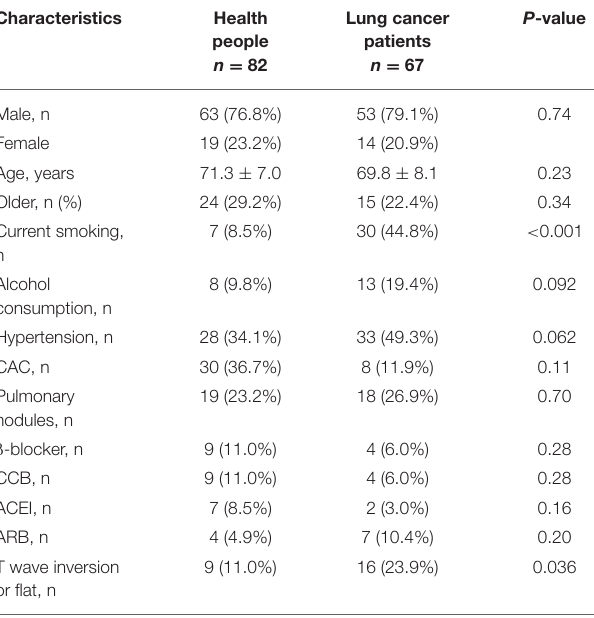
TABLE 2 | Characteristics of lung cancer patients with T wave inversion or